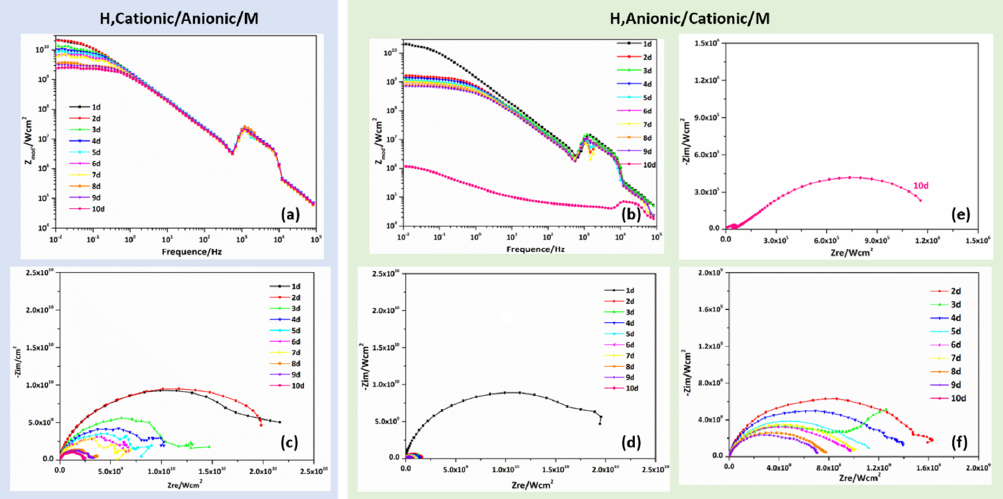
Figure 8. The anti-corrosion capability of the bipolar, hydrophobic coatings during immersion from one to ten days. ( a ) and ( b ) are Bode plots of the H, Cationic / Anionic / M system and H, Anionic / Cationic / M system, respectively. ( c ) is the Nyquist plot of the H, Cationic / Anionic / M system, and ( d ), ( e ), and ( f ) are those of the H, Anionic / Cationic / M system. The same results can be observed through the Nyquist plots. The results include the impedance change of the different bipolar, hydrophobic coating systems during immersion in 3.5 wt % NaCl solution for 10 days (Figure 8c, d, e, f ). A large radius of the impedance represents a higher corrosion resistance, and, thus, better anti-corrosion property. Since the radius of the impedance becomes smaller, the anti-corrosion performance of the coatings decreases. Moreover, it is observed that the H, Anionic/Cationic/M system loses protective ability at a faster rate than the H, Cationic/Anionic/M system when comparing the changes of the radius of the impedances. Therefore, the mangrove- inspired, bipolar hydrophobic coatings (H, Cationic/Anionic) can protect the substrate Q235 steel more significantly and for a much longer time.